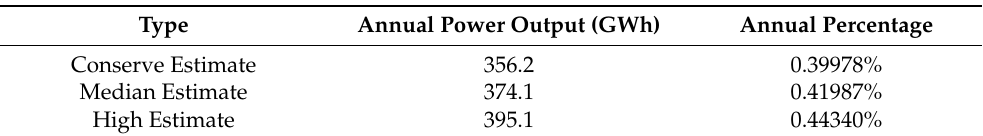
Figure 11 . Graphs of estimated GWh produced over a one-year period—2021—for potential Smith- land solar farm monthly (13.1: Upper ) and annually (13.2: Lower ) [27,29]. Table 3. Regarding estimates of yearly power generation by potential Smithland solar farm. Per- centages are based off average annual electricity consumption in Kentucky [27,29].